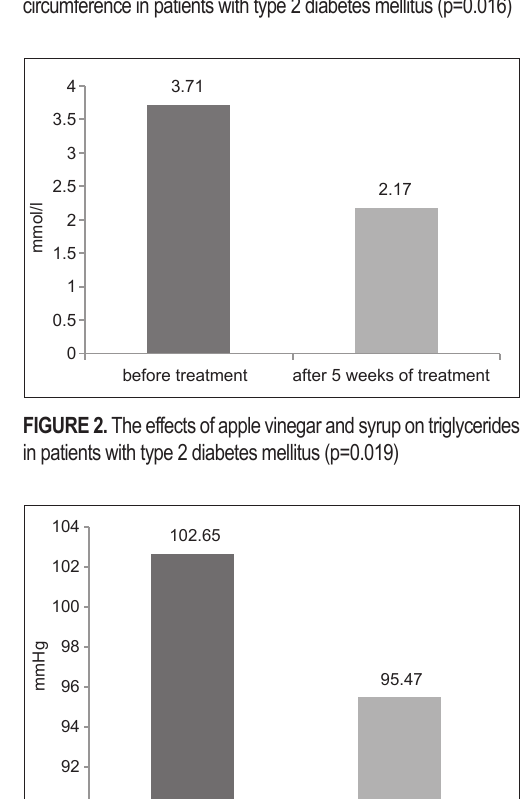
FIGURE 1. The effects of apple vinegar and syrup on waist circumference in patients with type 2 diabetes mellitus (p=0.016)